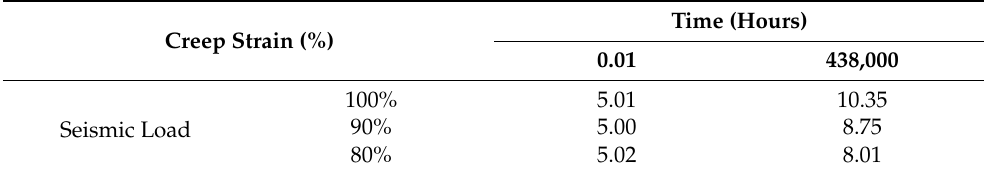
Table 10. Creep strain of LCP woven geotextile during creep test by 40% of UTS at initial and critical times.